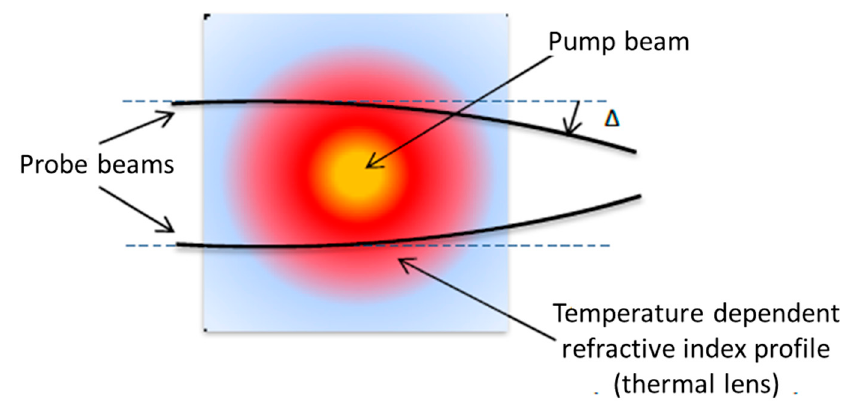
Figure 1. Sketch of the laser induced deflection (LID) measuring concept.